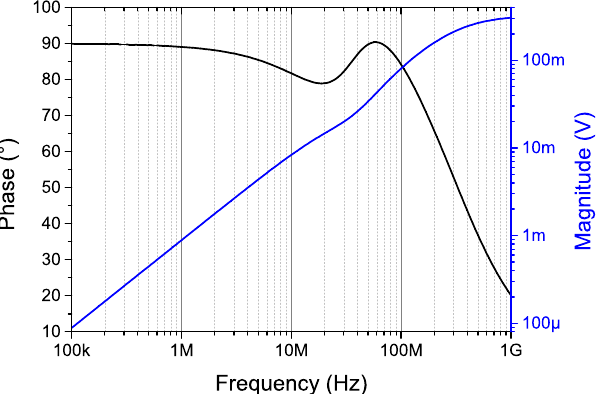
Figure 5. The voltage transfer function of the microtransformer as presented in Figure 3. The circuit is excited into the node V 1 with an AC source of unity magnitude, and the output is measured in node V 3 . Nodes V 2 and V 4 are grounded. V 3 . Nodes V 2 and V 4 are grounded.